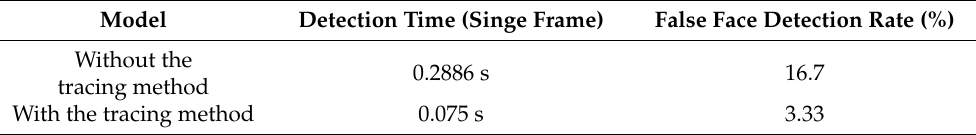
Table 4. Comparison of face detection with tracing method and without tracing method.